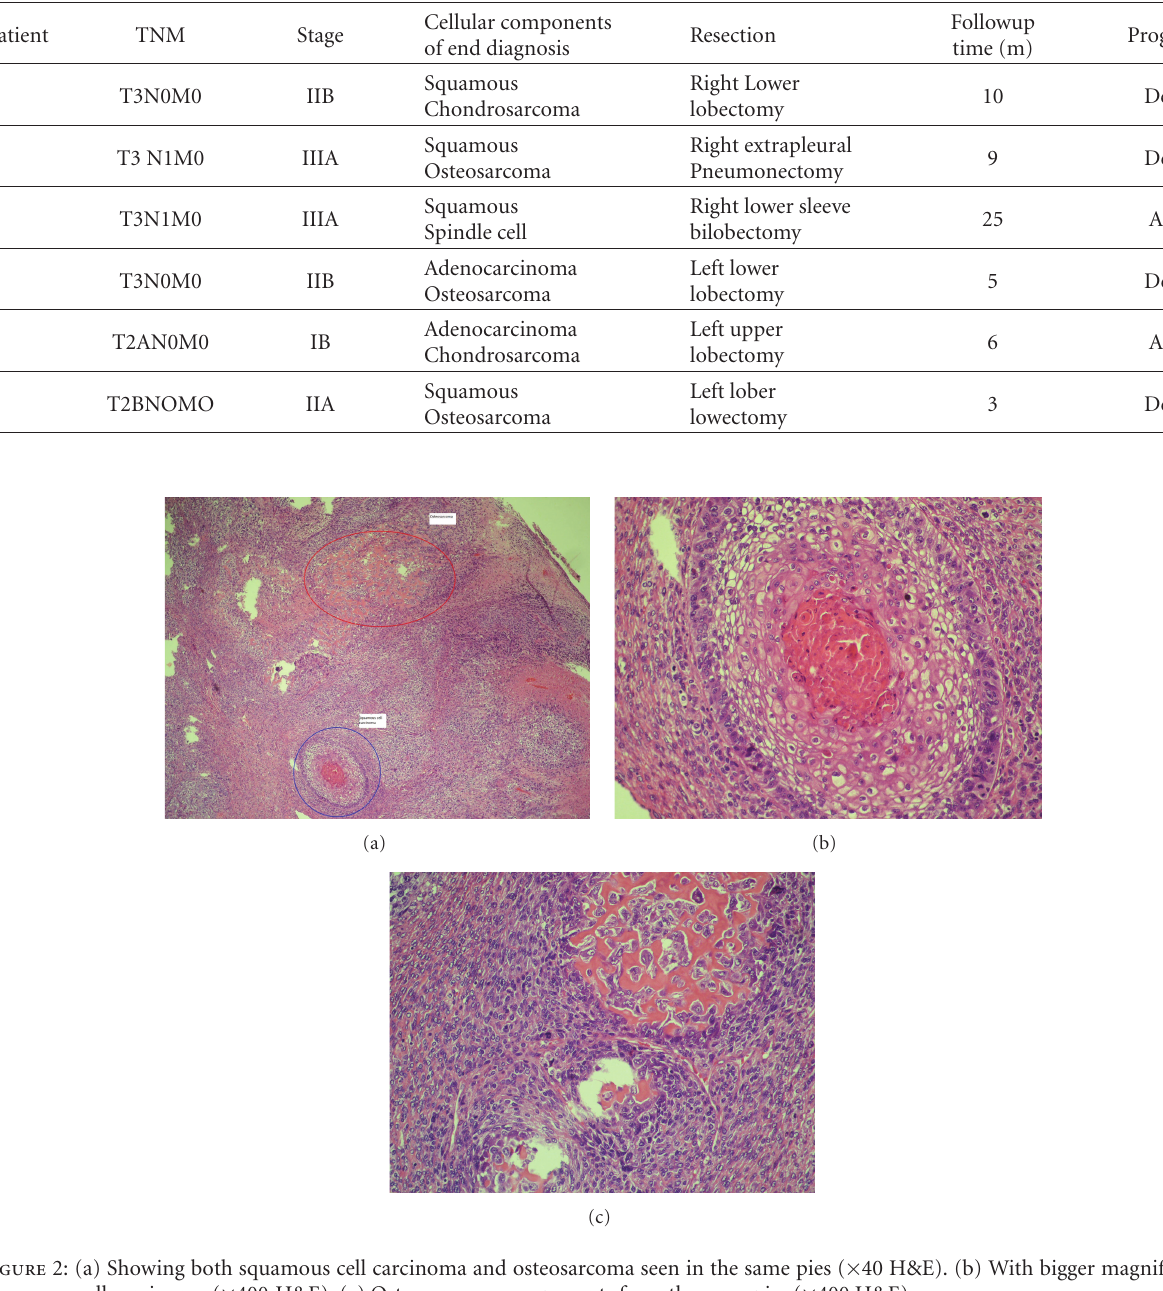
fissure invasion) in one patient, bilobectomy in another, and lobectomy in the others (Table